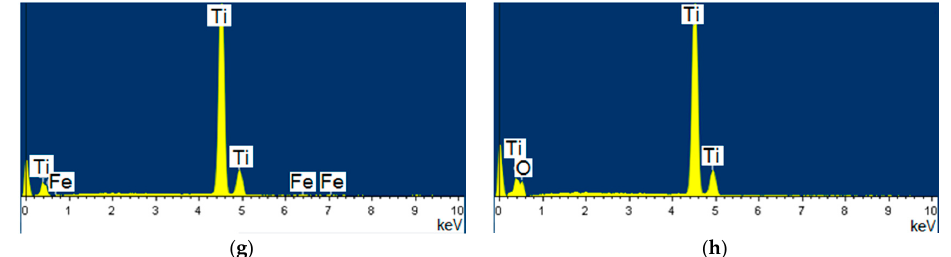
Figure 3. Micrographs of the coating cross-section and Energy Dispersive Spectroscopy (EDS) results: specimen produced in regime No. 1 ( a – d ) and No. 2 ( e – h ). A circle within red rectangle shows the location where EDS analysis was carried out.